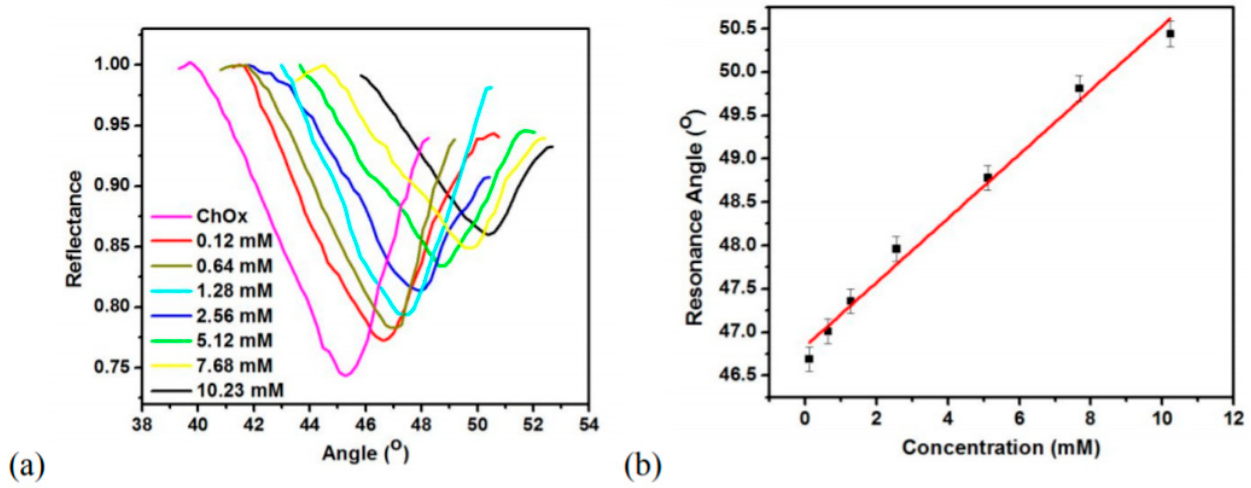
Figure 7. ( a ) SPR reflectance curve for ChOx/ZnO/Au prism corresponding to different cholesterol concentrations. ( b ) Calibration curve for variation in resonance angle with cholesterol concentrations. Reproduced with permission from [122].